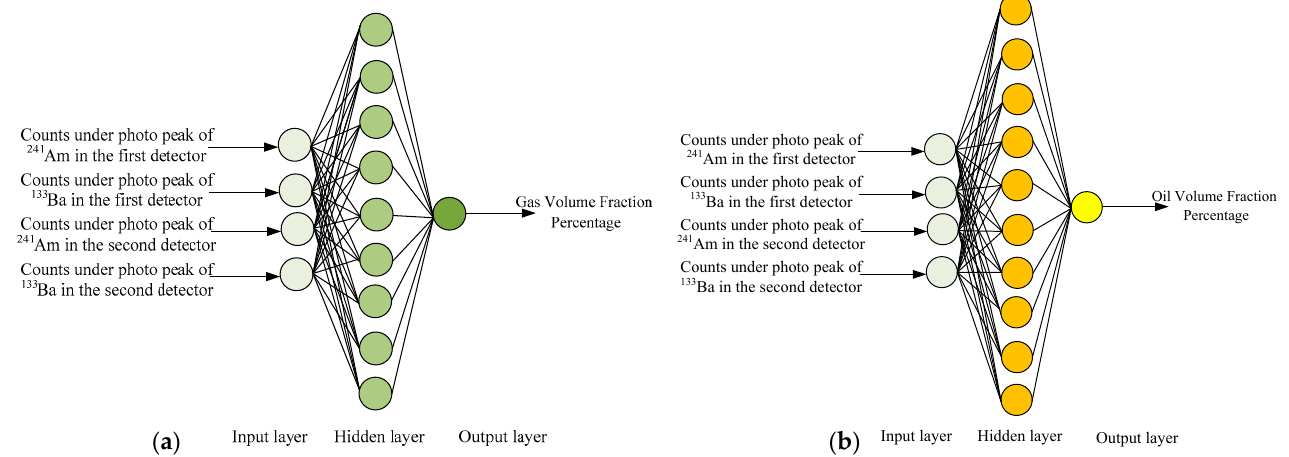
Figure 6. Architectures of presented MLP–LM models ( a ) for gas volume fraction measuring ( b ) for oil volume fraction measuring.